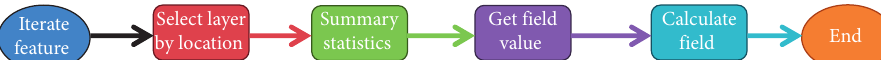
Figure 17: The algorithm determining the extent of damage observed under an earthquake wave in GIS.